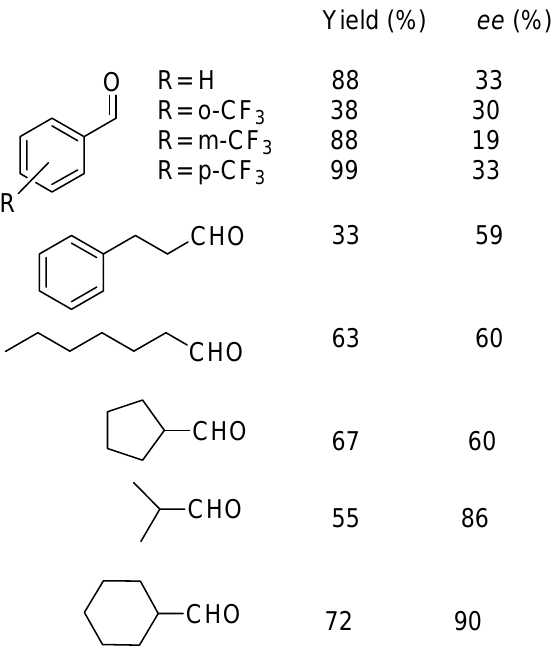
Figure 6. Bis (thio)urea type organocatalysts for the MBH reaction between cyclohexenone and 4-fluorobenzaldehyde catalyzed by